Question: Describe this figure in one sentence.
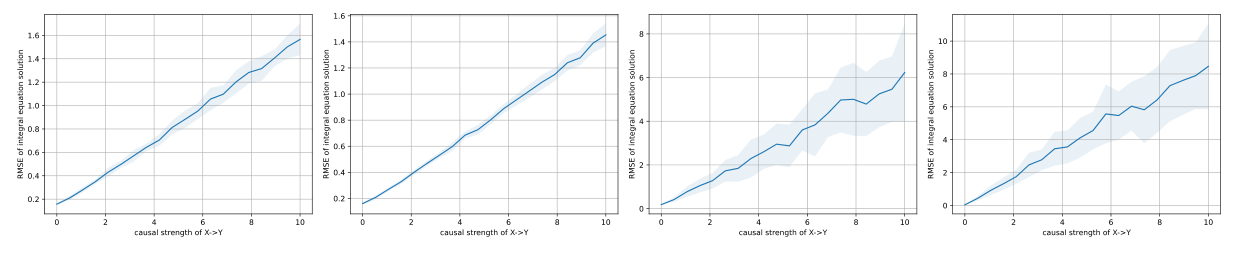
Answer: Insolubility of the integral equation when X ̸⊥⊥Y |U. We consider four examples, namely the linear Gaussian model, the linear nonGaussian model, the nonlinear additive noise model, and the general nonlinear models. For each example, we report the averaged residual of the best fit of the integral equation f(y|x) = R h(y, w)f(w|x)dw wrt to the correlation strength of X and Y . As we can see, when X and Y become strongly correlated (X ̸⊥⊥Y |U), the residual becomes non-zero, indicating the insolubility of the integral equation.